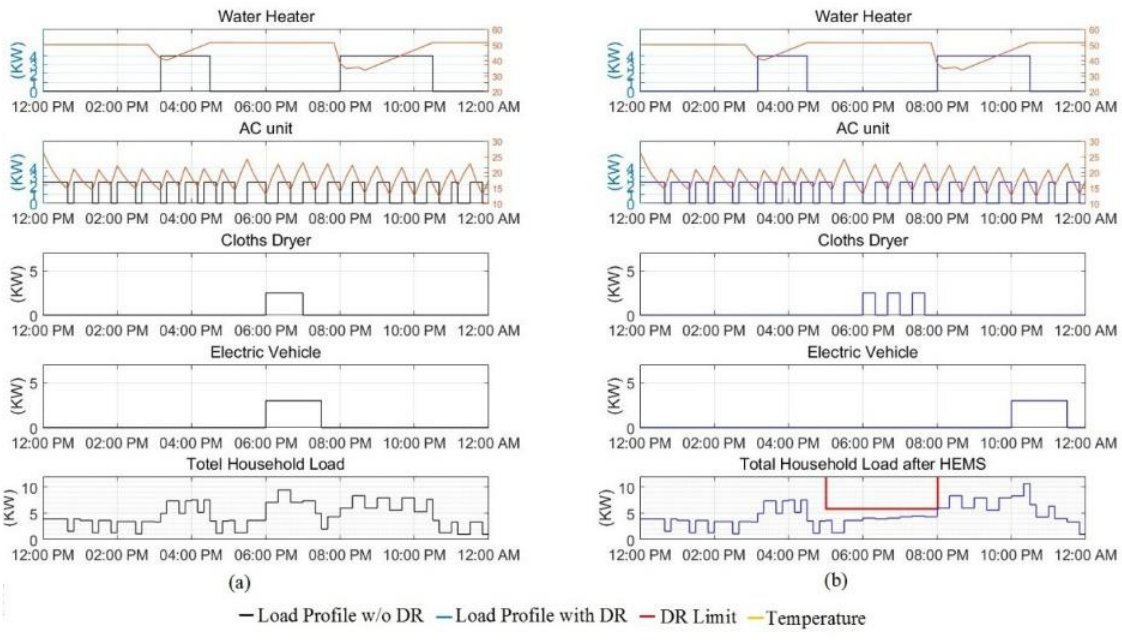
Figure 8. Home load profile for HEMS based on load power shifting. ( a ) No demand limit ( b ) 6 KW demand limit.